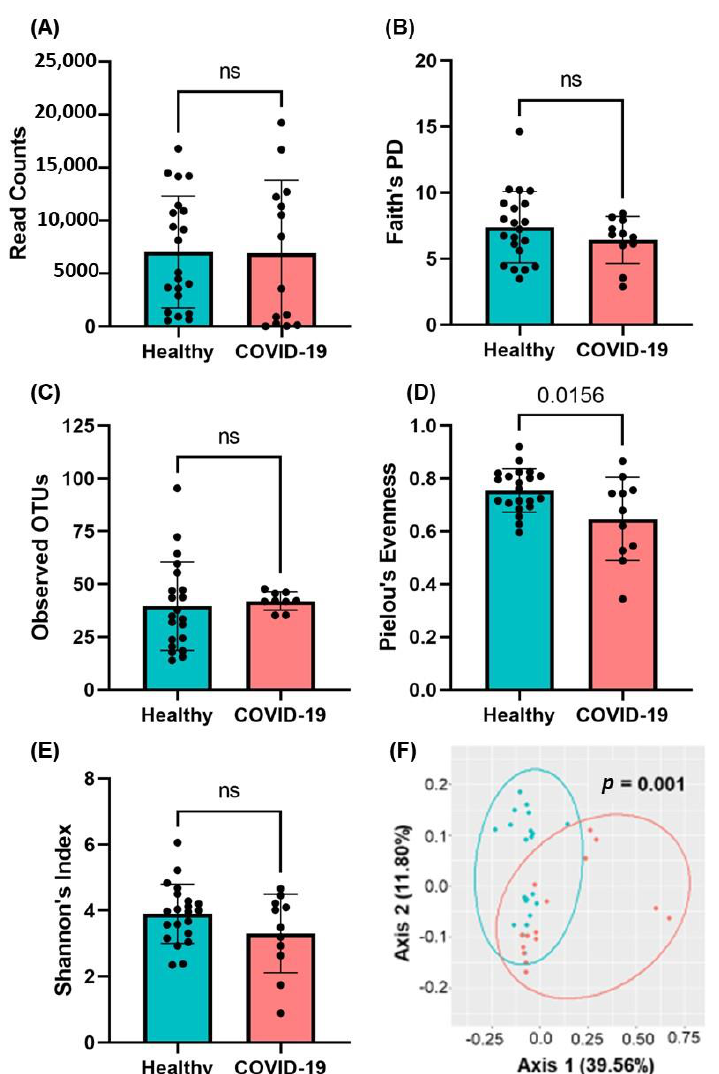
Figure 1. 16S rRNA analyses in the plasma of COVID-19 patients. ( A ) Total read counts and measures of alpha diversity—( B ) Faith’s Phylogenetic Diversity, ( C ) Observed OTUs, ( D ) Pielou’s Evenness, and ( E ) Shannon’s Dysbiosis Index—were calculated and indicate no aggregate changes in alpha diversity. Data are presented as mean ± S.E.M. Each dot represents a sample in the cohorts. Student’s t -test p -values are indicated where applicable (ns, p > 0.05). ( F ) Unsupervised 2D principal coordinates analysis (PCoA) of weighted UniFrac distance revealed significant alterations in beta-diversity in COVID-19 subjects (PERMANOVA p -value). Each dot indicates one patient plasma